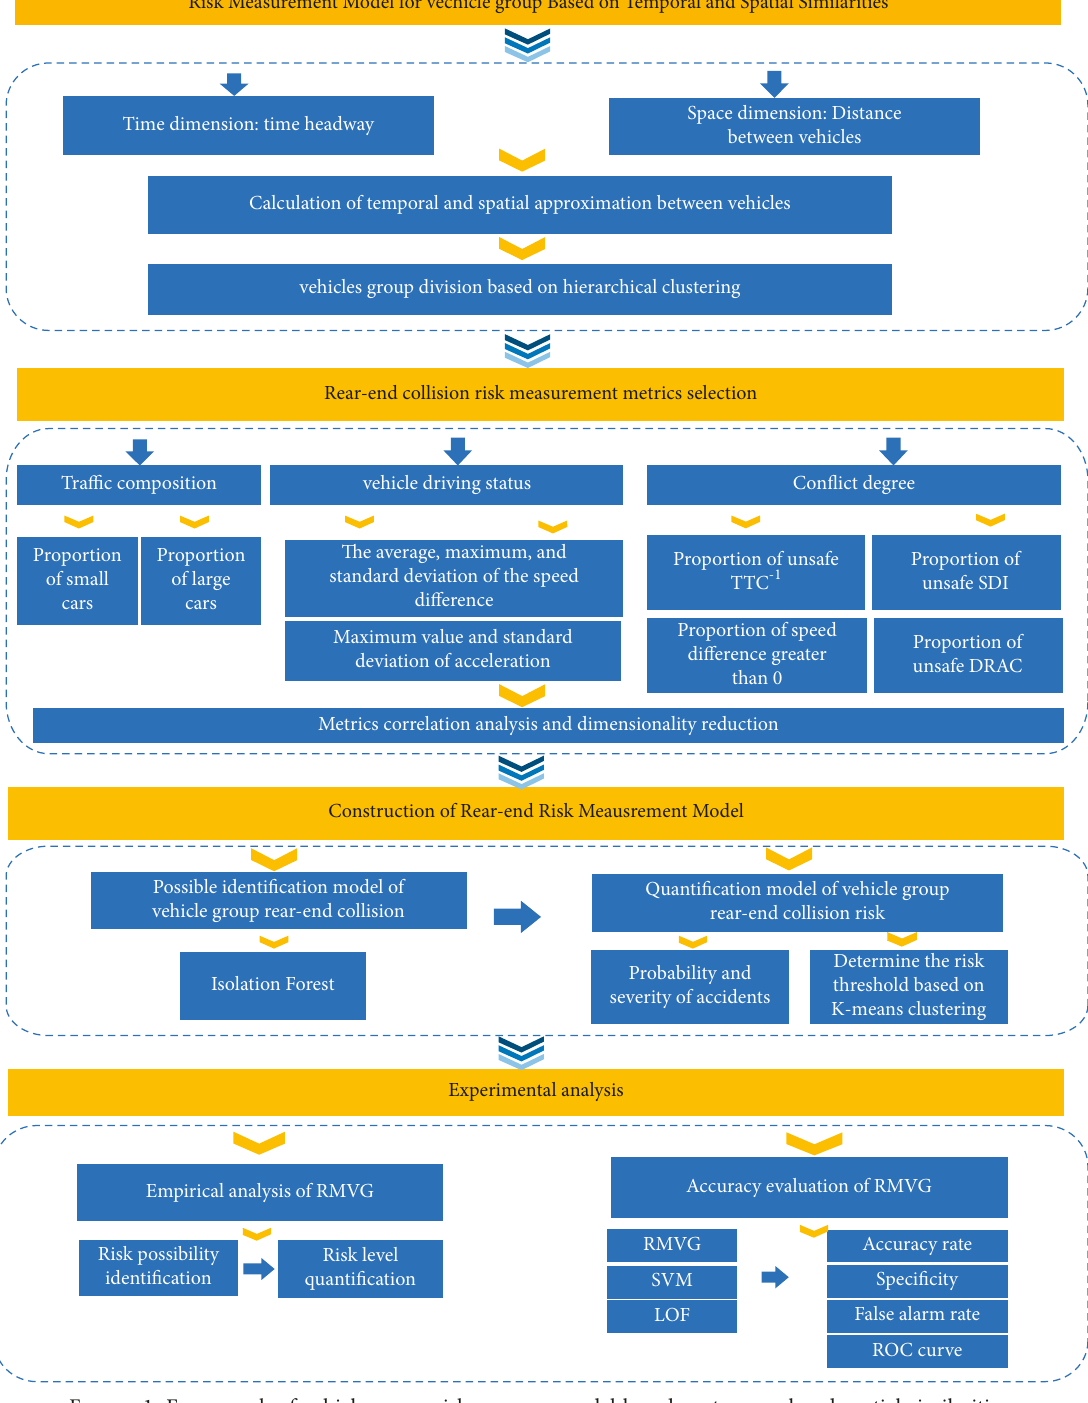
Figure 1: Framework of vehicle group risk measure model based on temporal and spatial